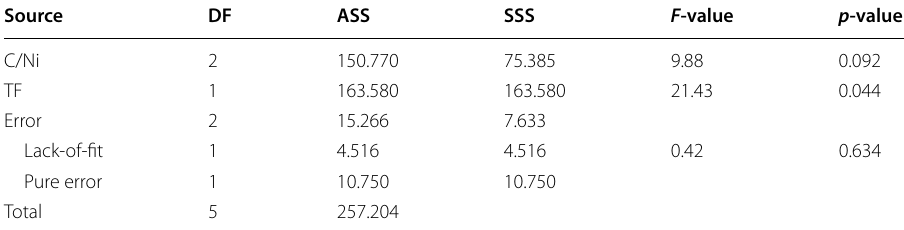
DF degrees of freedom, ASS adjusted sum of squares, SSS sequential sums of squares Table 10 Tukey’s test associated with C/Ni and TF effects on OM N Mean